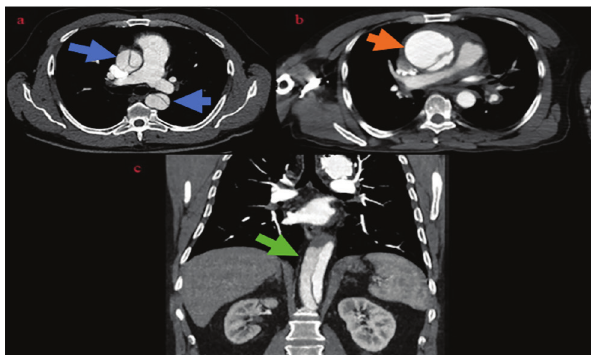
Figure 1 - Dissection types according to De Bakey classification (a: Type I, b: Type II, c: Type III).